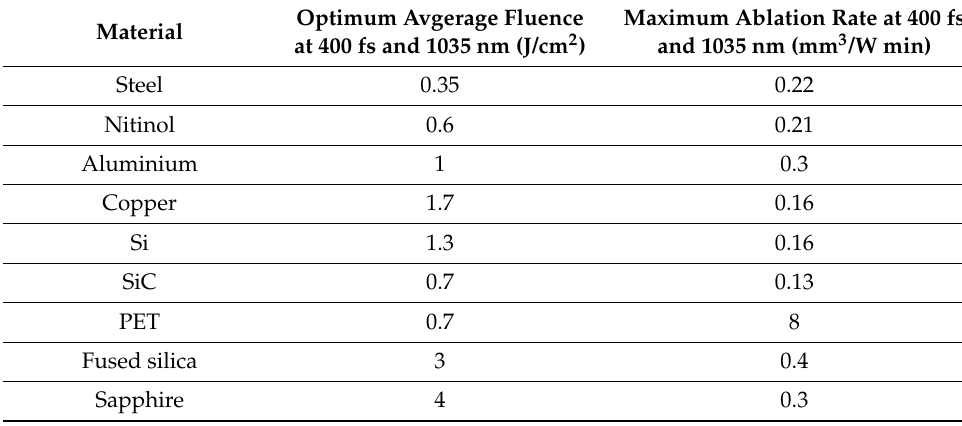
Figure 3. Energy penetration (red) and volume heated via heat conduction (yellow) or different pulse durations [47].